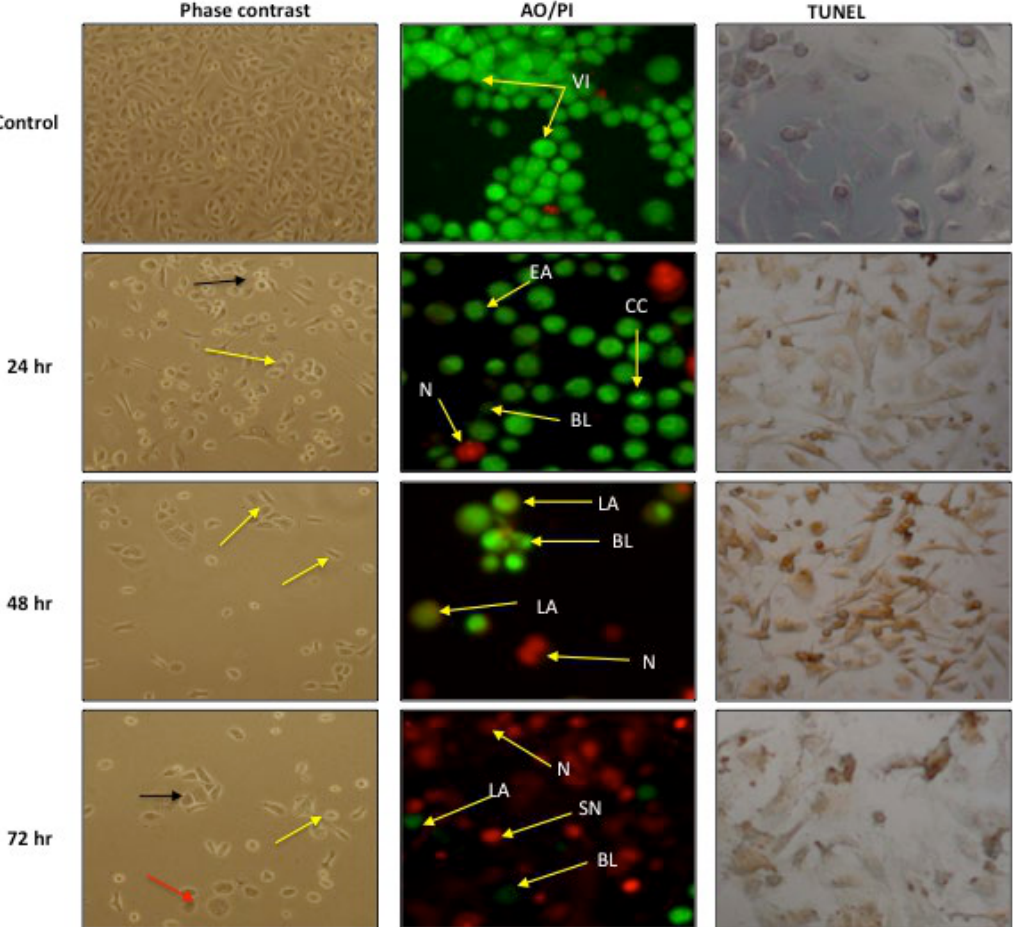
Figure 4. Images of stained PC-3 cells treated with GMG-ITC (3.5 µg/mL) in a time-dependent manner. Phase contrast images of apoptotic PC-3 cells with arrows indicating chromatin condensation in the cell nucleus with occasional enucleation; (black arrow), elongated lamellipodia (yellow arrow), and cells detached from substrate (red arrow). AO/PI fluorescence image of PC-3 cells with arrow indicating (BL) blebbing, (CC) chromatin condensation, (EA) early apoptosis, (LA) late apoptosis, (N) necrosis, (SN) secondary necrosis, and (VI) viable cells. 40× magnifications. TUNEL assay images of PC-3 cells with darkened stains indicating DNA fragmentation within the cells. Magnification 400×.